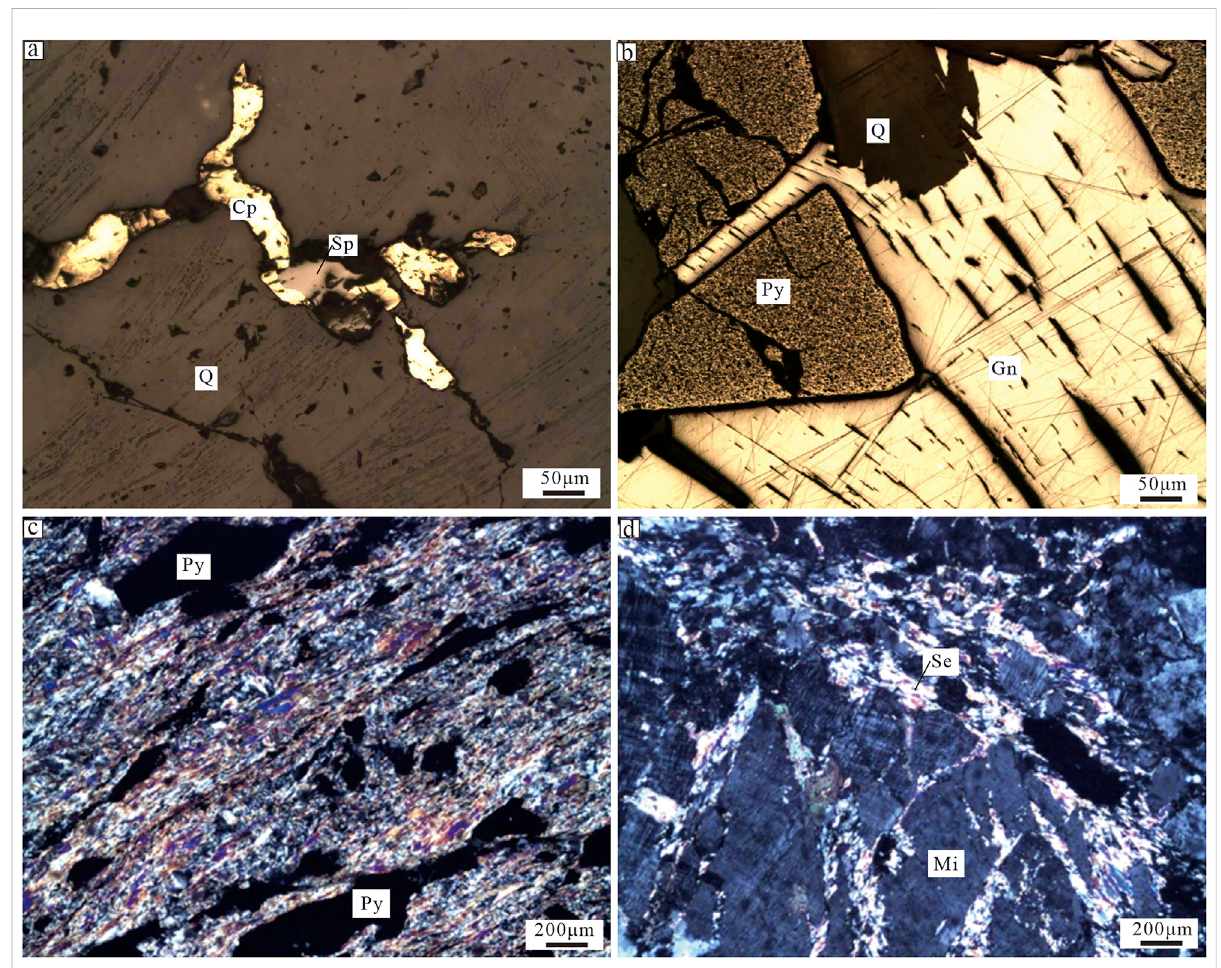
FIGURE 4 Petrographic photos showing ore minerals and alterations in the Dongtongyu (A) - Chalcopyrite and sphalerite veinlets in a quartz vein, Sample TY020b, RL ( − ); (B) - Pyrite was replaced by galena in a quartz vein, Sample TY052a, RL ( − ); (C) - Pyrite in mylonite, TL (+); (D) - Cataclastic microcline, and sericite in fractures, TL (+). Cp-chalcopyrite; Sp-sphalerite; Q-quartz; Py-pyrite; Gn-galena; Se-sericite;